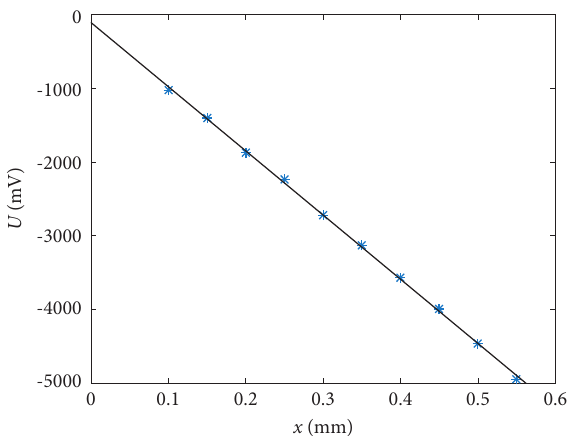
Figure 5: Static radial calibration curve of No. 0